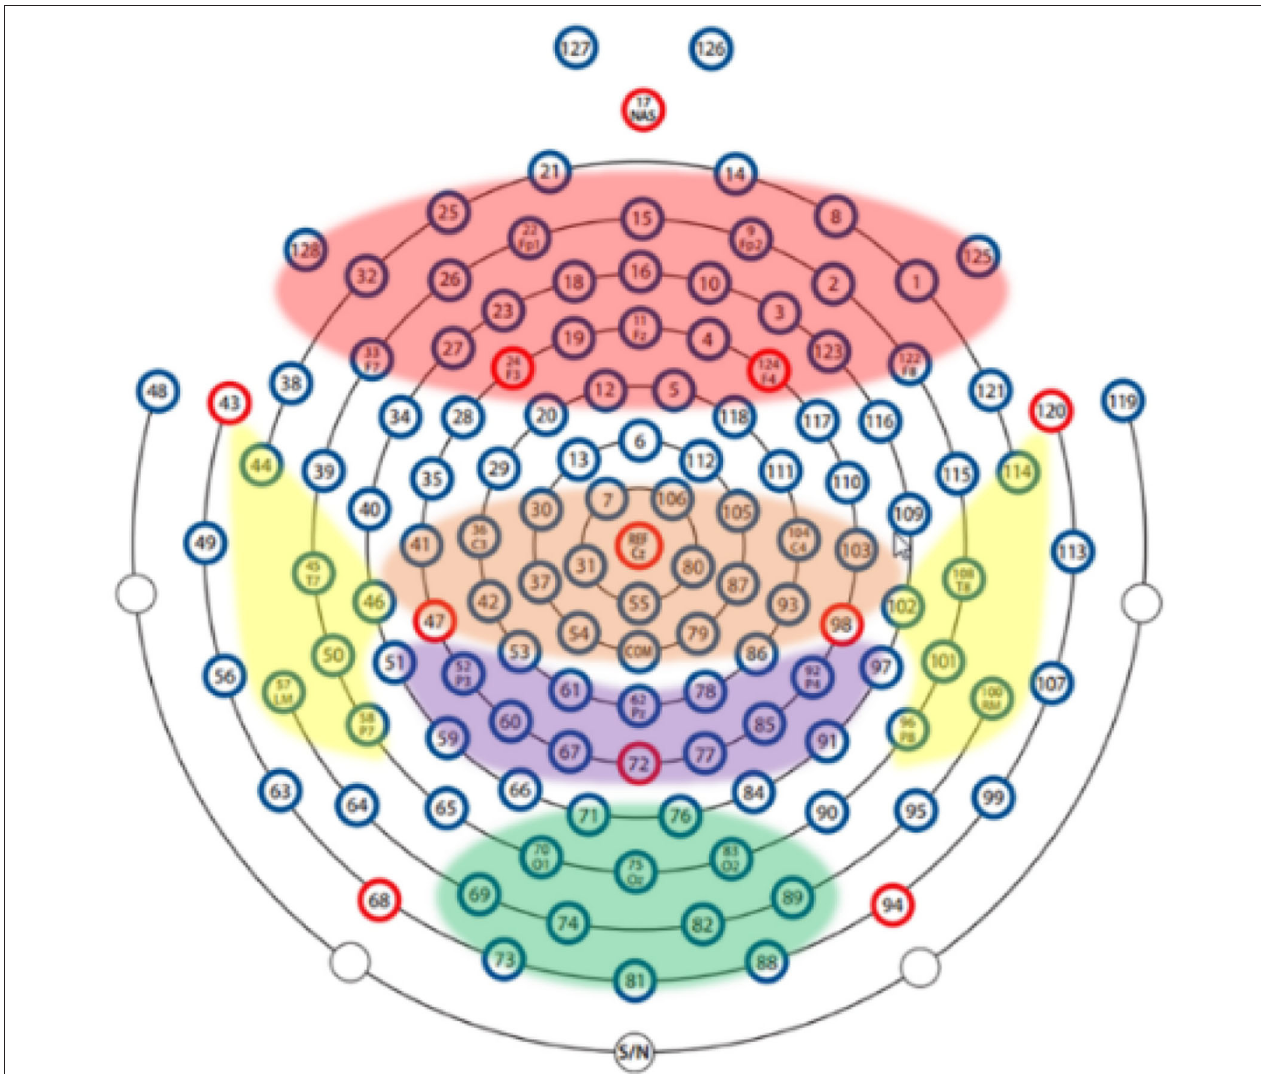
FIGURE 5 | The division of the brain between different brain